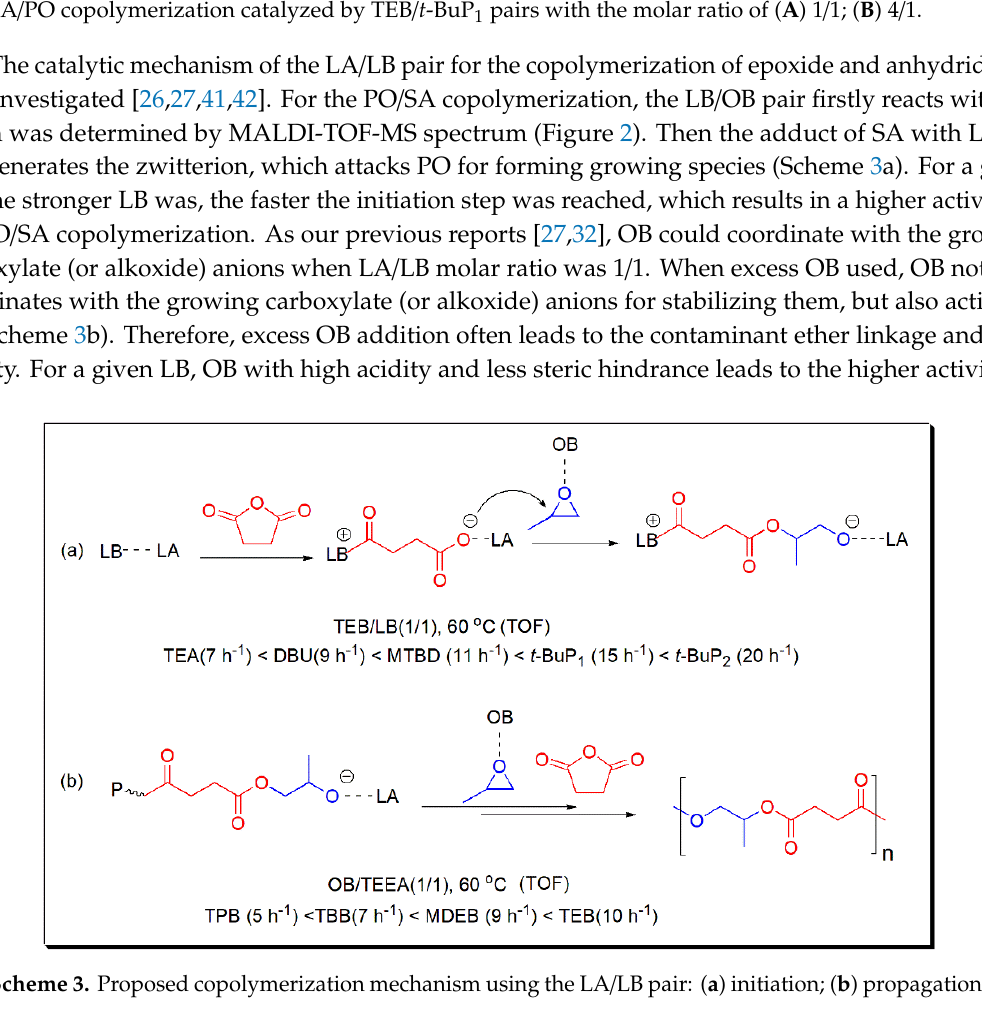
Scheme 3. Proposed copolymerization mechanism using the LA/LB pair: (a) initiation; (b) propagatio